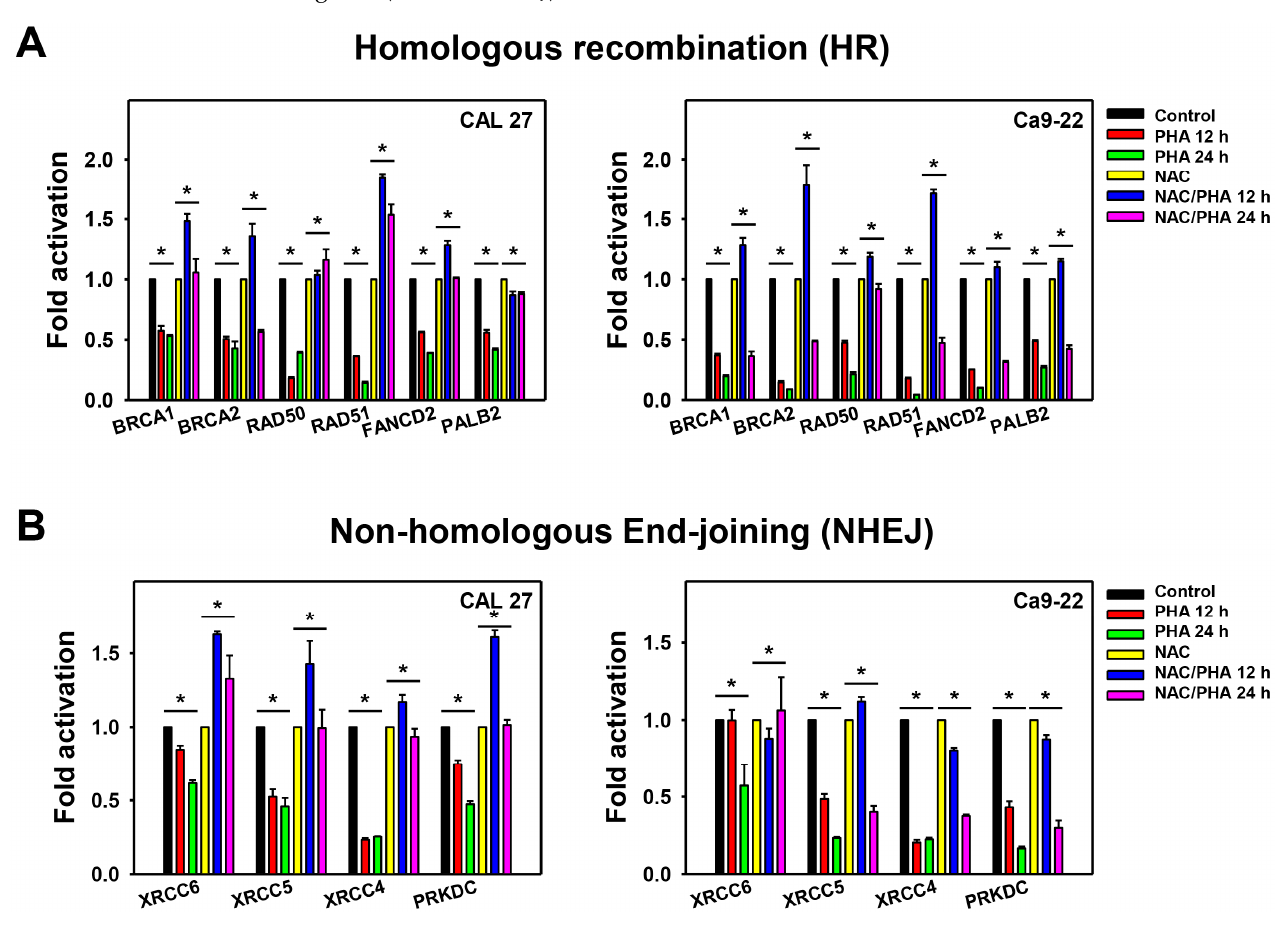
Figure 9. PHA inhibits mRNA expressions of DNA repair genes in oral cancer cells. NAC (10 mM for 1 h) was added to cells before 0, 12, and 24 h treatment with PHA (control (0.1% DMSO medium) and 2 μ M), i.e., control (PHA-untreated and NAC only), PHA 12 h vs. NAC/PHA 12 h, PHA 24 h vs. NAC/PHA 24 h. ( A , B ) mRNA expression of HR and NHEJ genes. mRNA expressions were adjusted with the GAPDH gene. Data, means ± SDs ( n = 3 independent experiments); * indicates p < 0.05